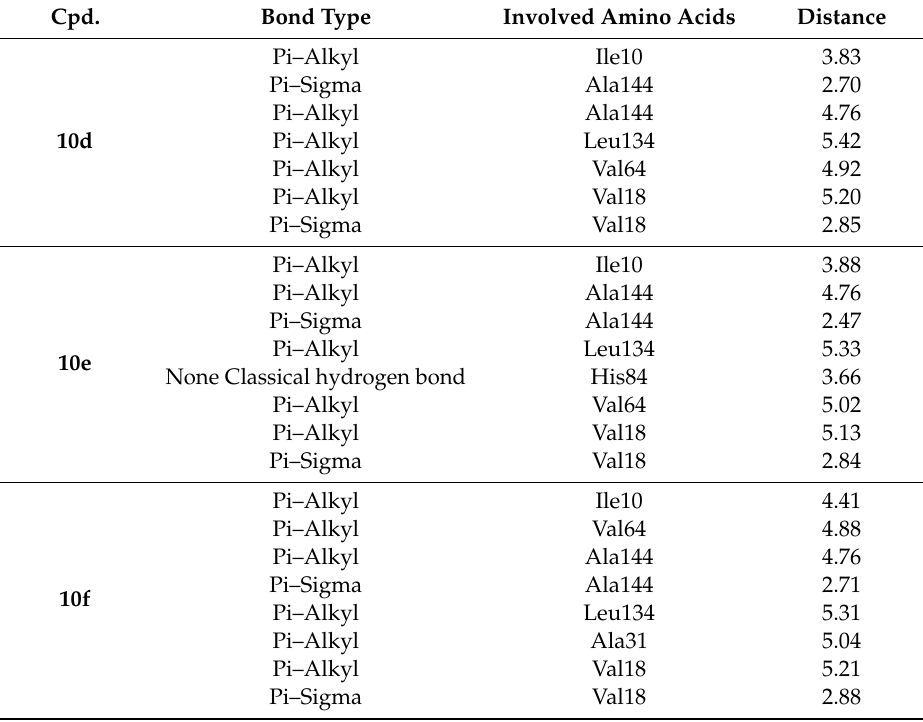
Table 5. The interaction energy and bonding between benzimidazoles 10d – f and the CDK2 active site. Cpd.